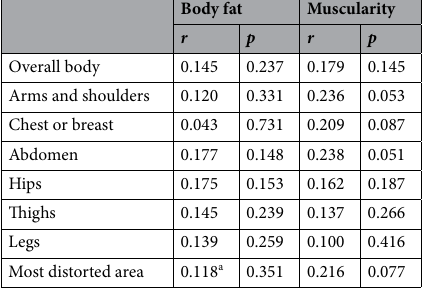
Table 3. Pearson’s correlations (r) between EHQ scores and implicit body fat and muscularity distortion for various body areas. a n =